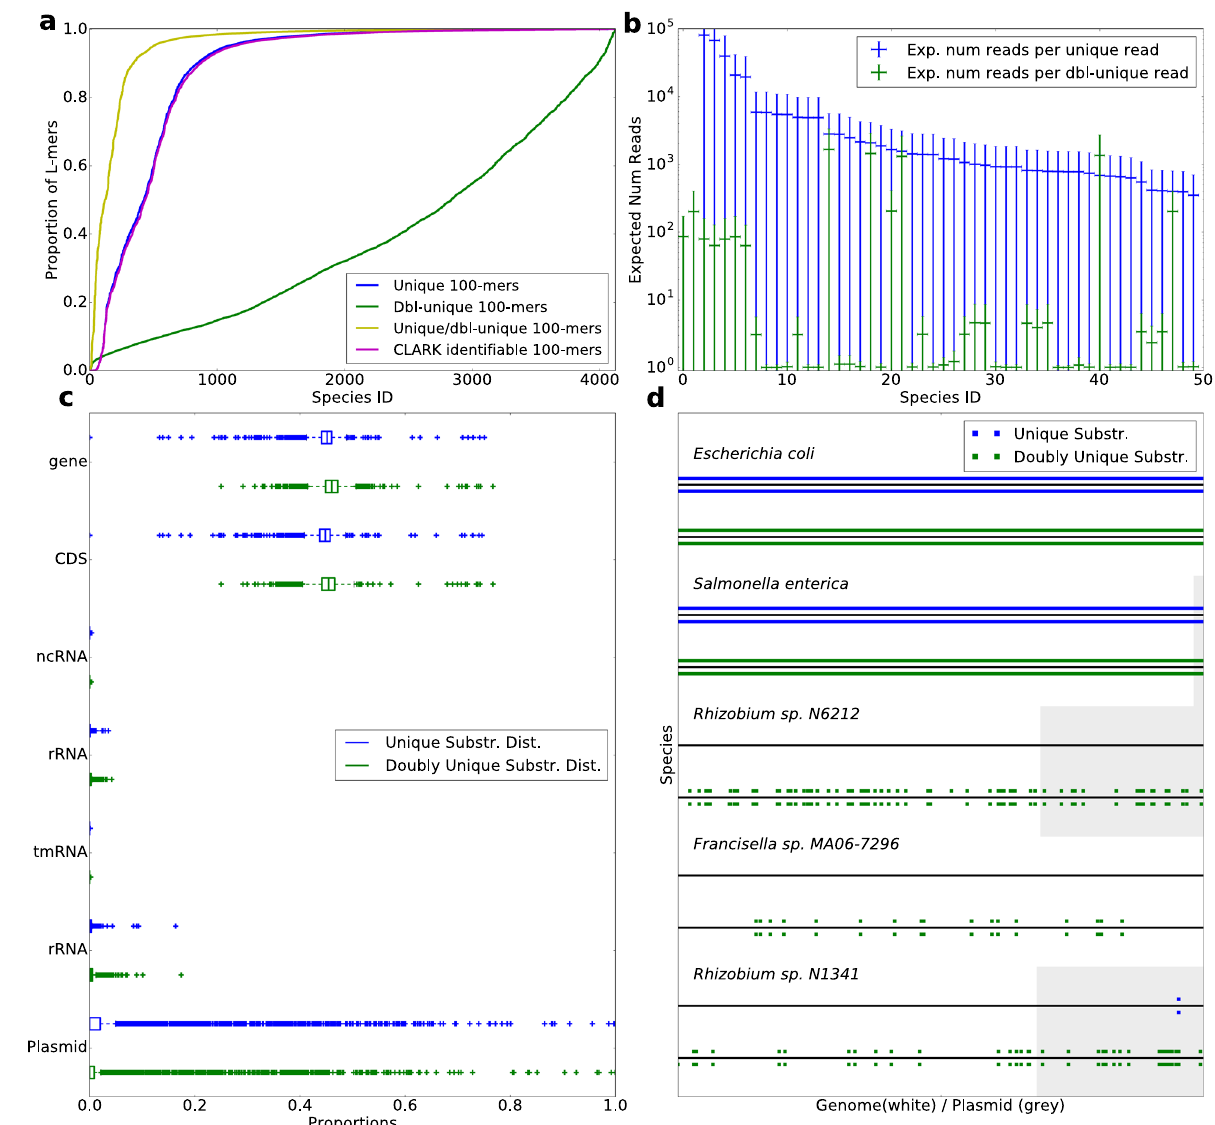
Fig. 1 | The advantage of using variable-length and doubly-unique substrings. a The proportionof L -mers(for L =100)thatinclude aunique substring (inblue),a doubly-uniquesubstring(ingreen),oreitherauniqueoradoubly-uniquesubstring (in yellow)in the species-level-bacteria dataset of 4122 genomes from NCBI RefSeq; these L -mers, when presented as reads are utilizable by CAMMiQ (when L max =100).Alsoincludedaretheproportionof L -mersthatincludeaunique k -mer ( k =30) and thus are utilized by CLARK (in purple).For each plot, the genomes are independently sorted with respect to the corresponding proportions in ascending order. b The expected number of reads (of length L =100) needed to capture one readcontainingauniquesubstring(inblue)aswellasonereadcontainingadoubly- uniquesubstring(ingreen)inthe50genomeswiththelowestproportionofunique